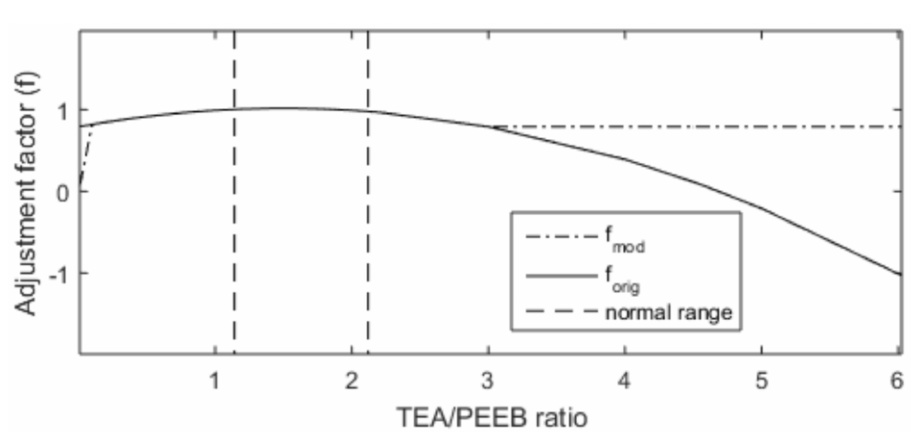
Figure 9. Adjustment of the kinetic